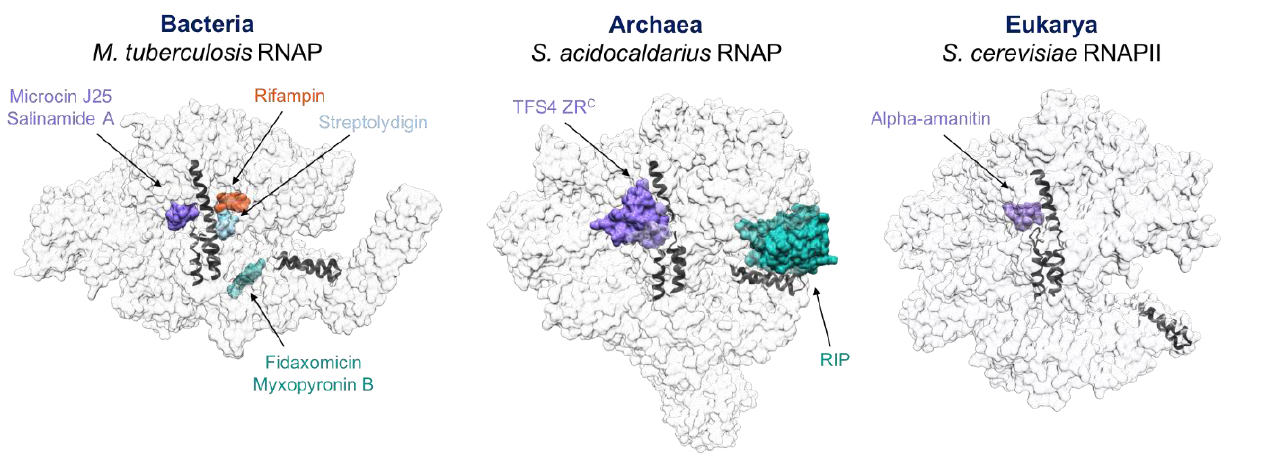
Figure 4. RNAP-specific antibiotics that are reminiscent of RIP and TFS4 action. Schematic illustration of the RNAP target sites for a selection of antibiotics and inhibitors. The RNAPs are shown as grey surfaces in transparency, the antibiotics and the inhibitors TFS4 and RIP are shown as surface representation using a colour code based on closely related binding sites: medium purple for the NTP-entry channel, orange for the RNA binding site, light sky blue for the BH/TL site, and sea green for the clamp region. All bacterial structures were superimposed against subunit beta; pdb codes: 5uh6 (Rifampin) [74], 2a6h (Streptolydigin) [75], 4yfx (Myxopyronin B) [76], 6fbv (Fidaxomicin) [77], 6n60 (Microcin J25) [78], 4mex (Salinamide A) [79]. S. cerevisiae RNAPII was obtained from pdb code 3cqz [80]. For clarity, only one compound for target site is